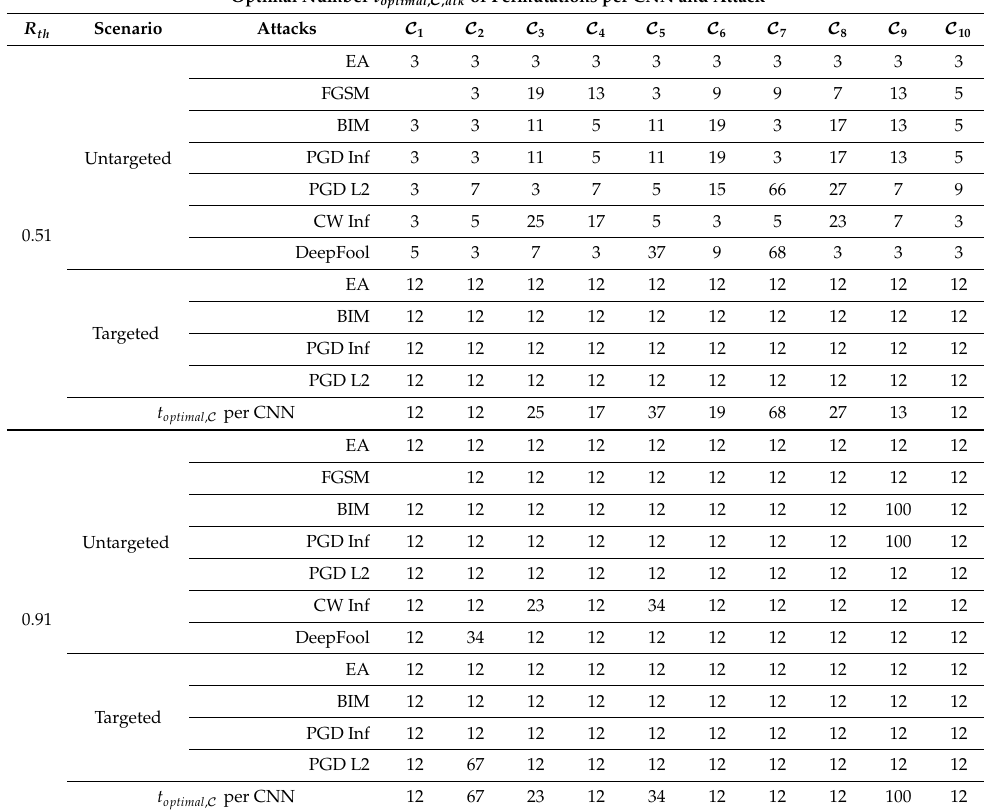
Table 16. For R th = 0.51 and 0.91, the optimal number of permutations t optimal , C , atk per CNN and attack, and the optimal number of permutations t optimal , C per CNN valid for all tested attacks (potentially relevant to assess unknown